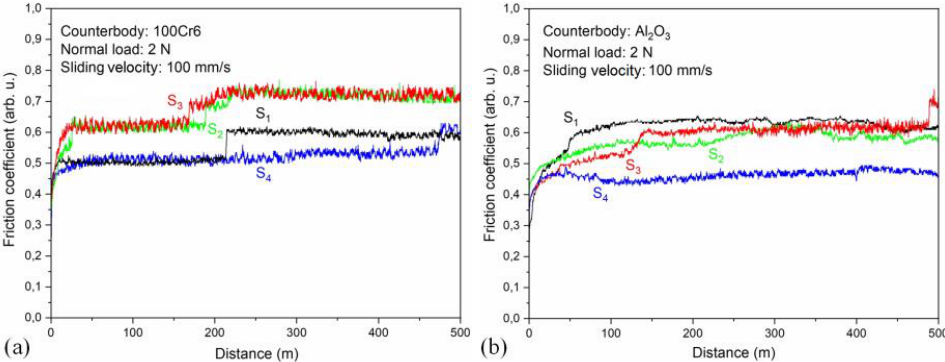
Figure 12. Coefficient of friction as a function of sliding distance measured by ball-on-disc method: ( a ) 100Cr6, ( b ) Al 2 O 3 counter bodies on the (Cr 1−x Al x )N coating.